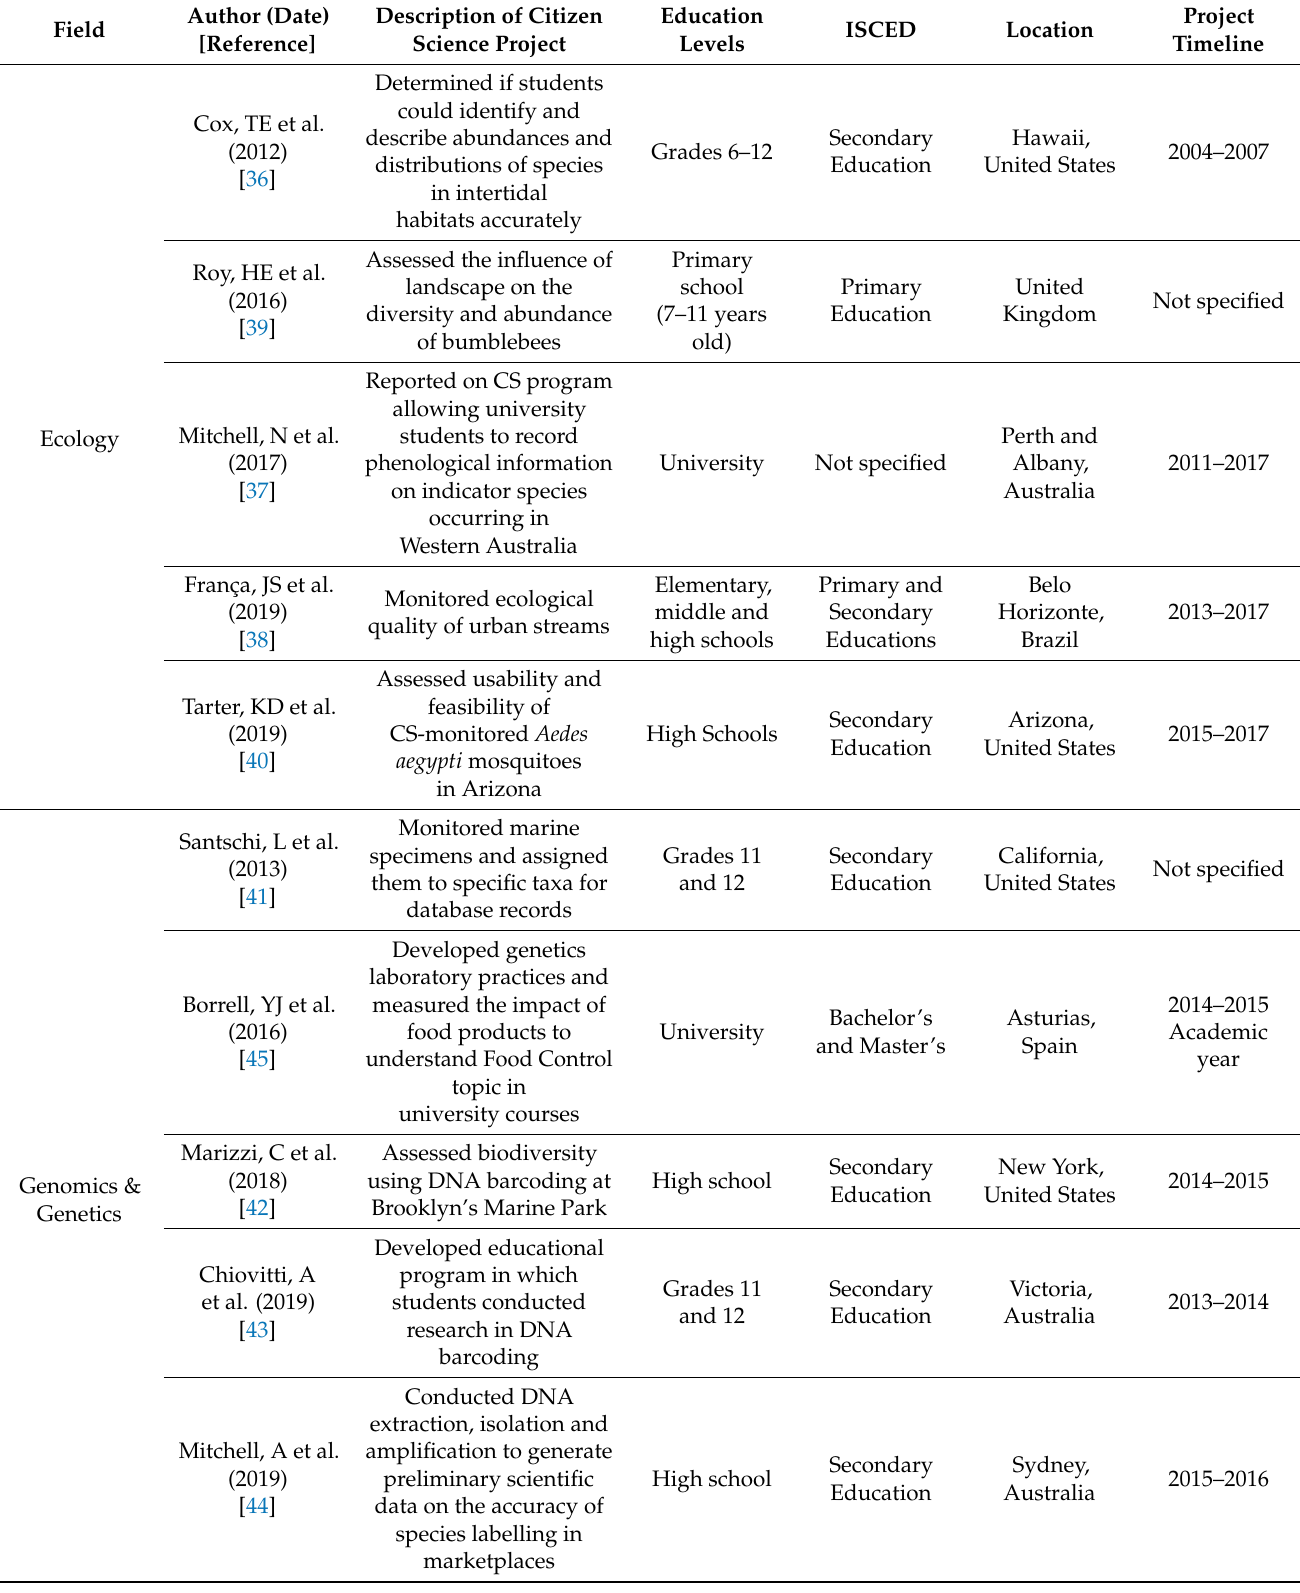
Table 1. Summary of school citizen science projects described in scientific